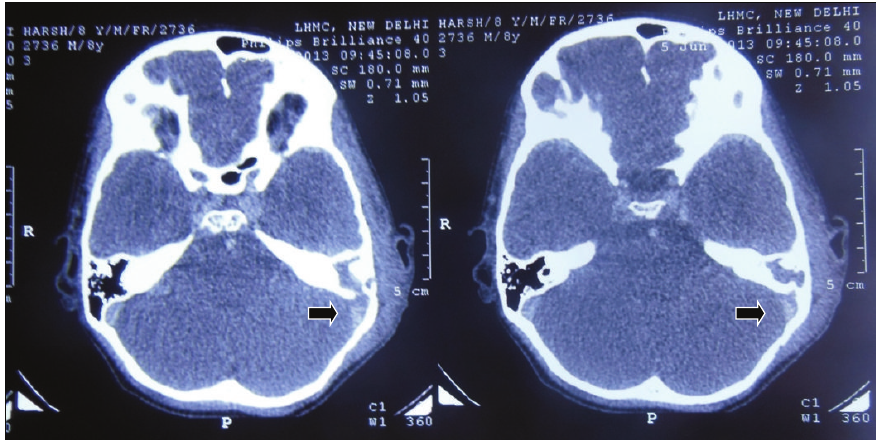
Figure 1: Contrast-Enhanced CT scan showing lateral sinus thrombosis (arrow).